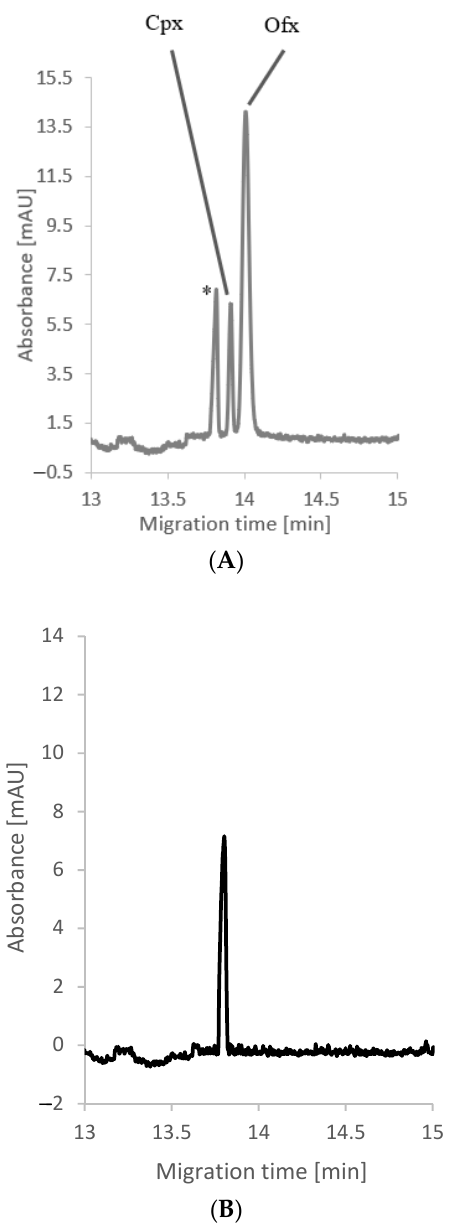
Figure 1. ( A ) Representative electropherogram obtained for meat tissue spiked with Cpx and Ofx (final concentration 1.4 ppm (4 nmol/g tissue)). * The peak corresponds to the non-identified component of the sample. ( B ) Representative electropherogram obtained for blank meat tissue.